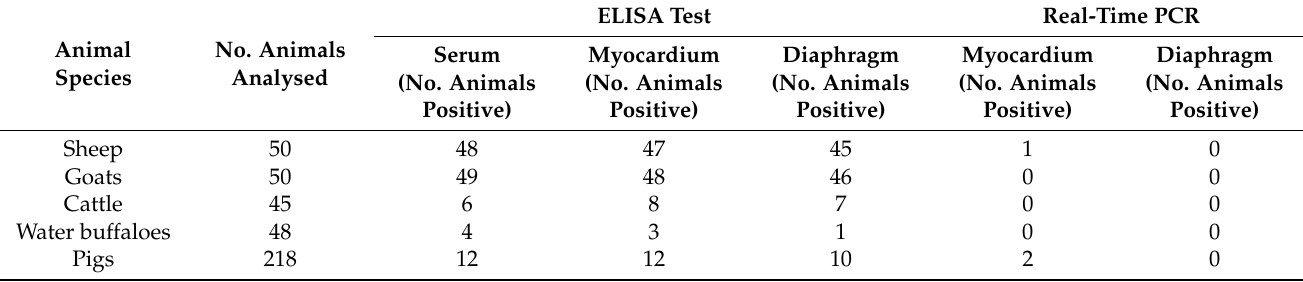
Table 4. Results (positivity to T. gondii ) of serological and molecular analysis, for each matrix and according to animal